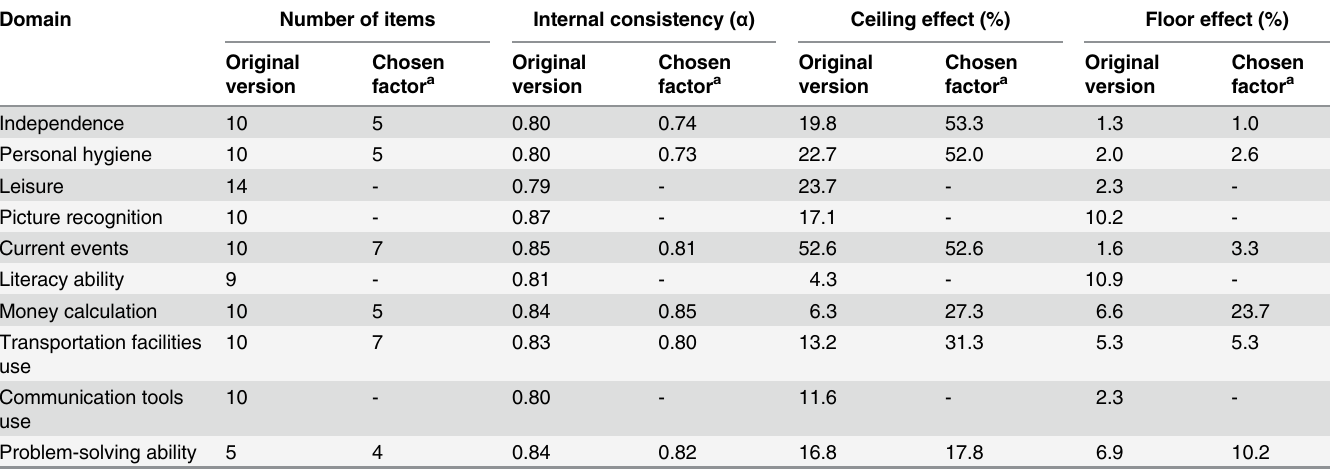
Table 4. Descriptive statistics and Cronbach ’ s α of the 10 domains of the ADLRS-III (n = 304).